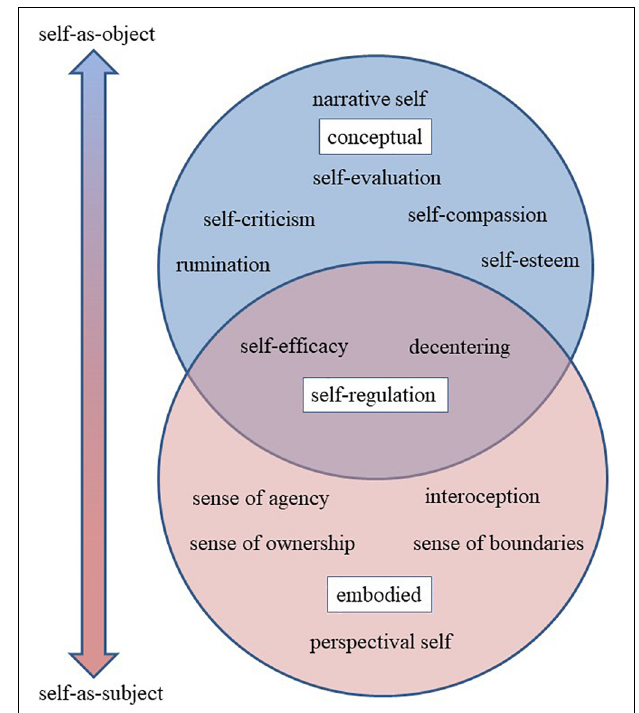
FIGURE 1 | Schematic diagram of self-related